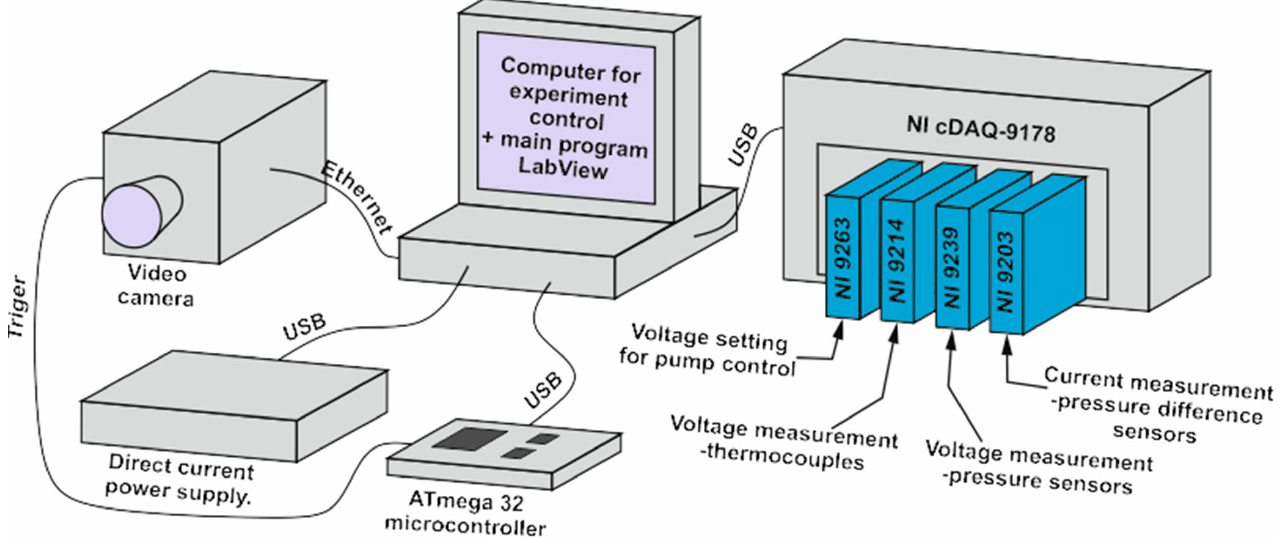
Figure 3. The control and data acquisition system.